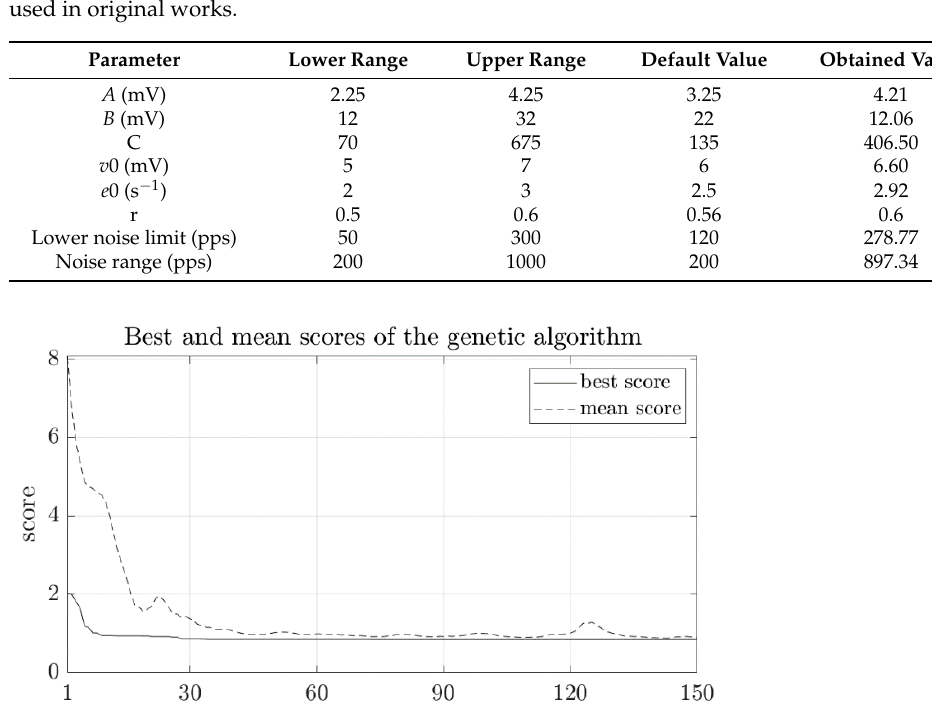
Table 4. Values of parameters obtained for the measured signal. Values in column “default” were used in original works.